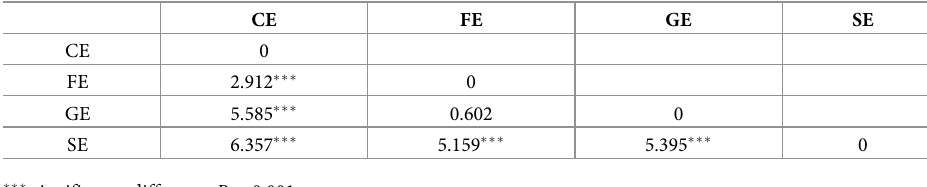
Table 5. Mahalanobis distance between different ecotypes.